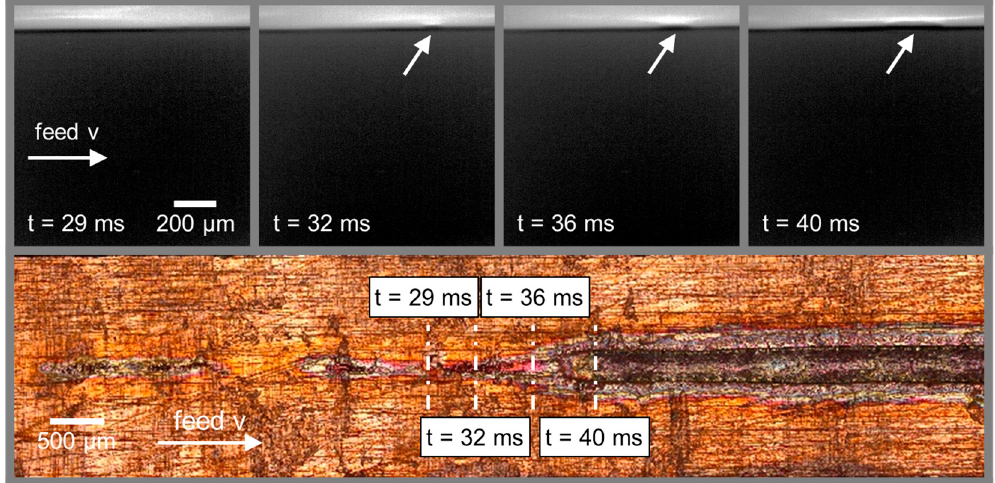
Figure 7. (Upper) X-ray video sequence of laser beam welding of copper using 1030 nm laser radi- ation, P = 4000 W, v = 133.3 mm/s, d F = 800 μ m; ( lower ) corresponding top view of the weld seam. radiation, P = 4000 W, v = 133.3 mm/s, d F = 800 µ m; ( lower ) corresponding top view of the weld